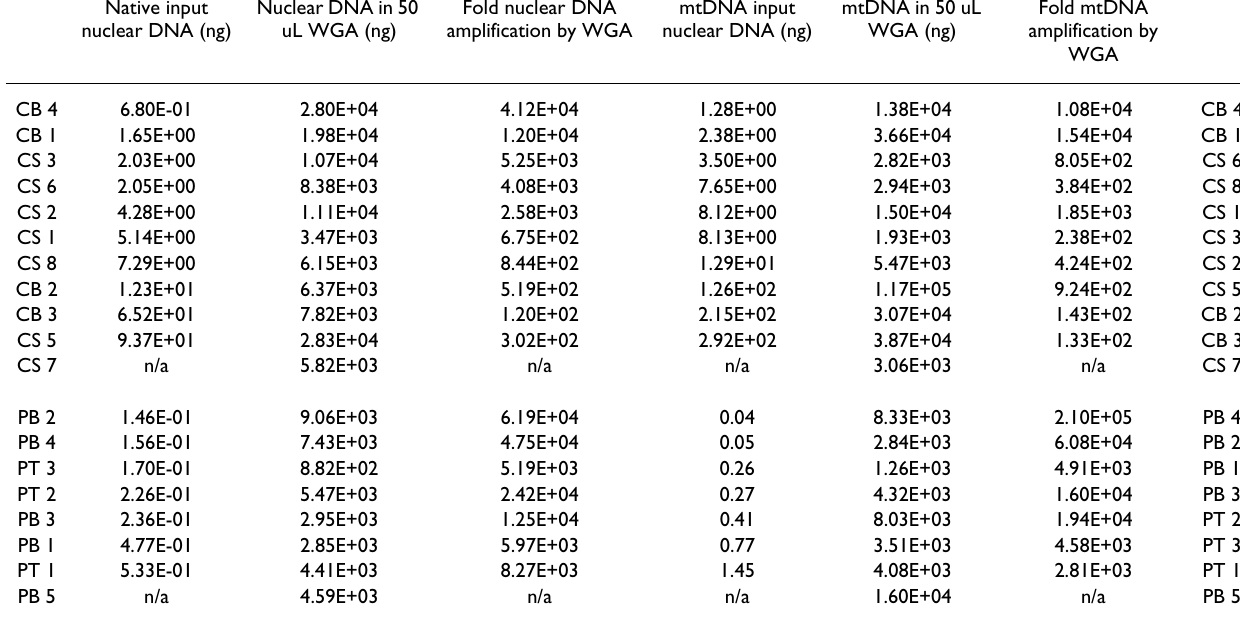
Table 1: Real-Time PCR: nuclear and mtDNA native and WGA samples Native input nuclear DNA (ng)